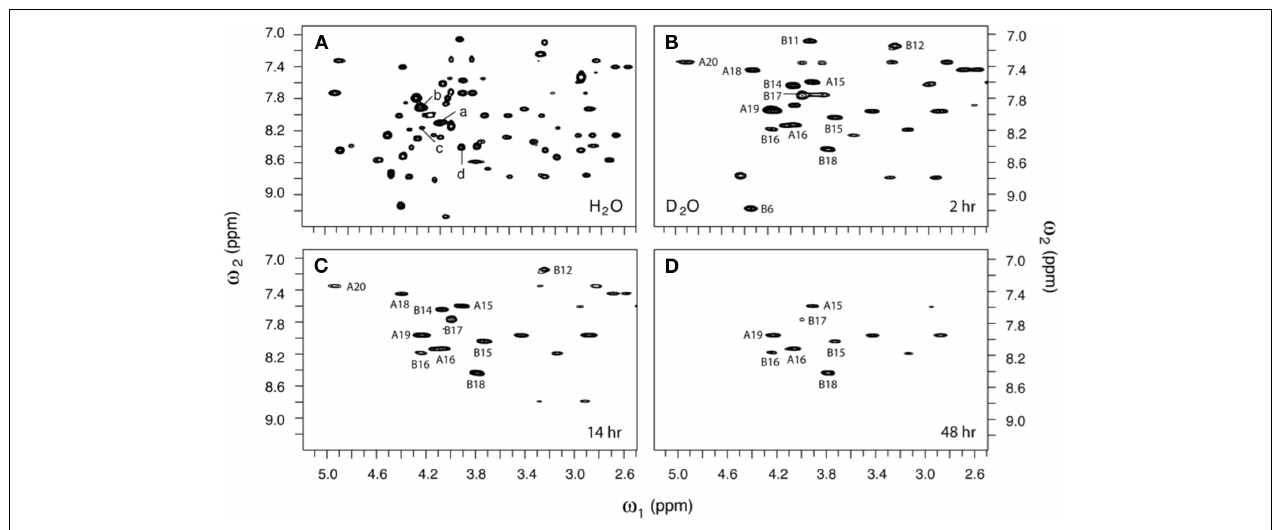
FIGURE 6 |Two-dimensional 1 H-NMR studies of amide-proton exchange in D 2 O (pH 3.0 and 25˚C). (A) BaselineTOCSY spectrum in H 2 O. Selected H N –H α cross-peak assignments are as follows: (a) Leu A16 , (b)Tyr A19 , (c)Tyr B16 ,